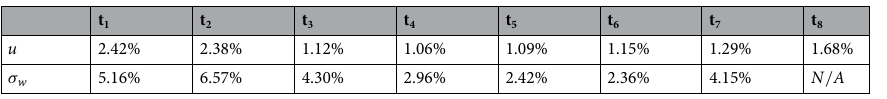
2 i , j ( f num − f ana ) where f is for u and σ w on a cross-section of the pipe at 2 ana i , j f (cid:31) (cid:30) (cid:30)